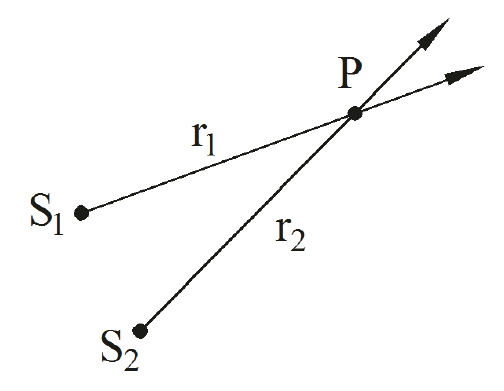
Figure 9: Two waves meet at point P.